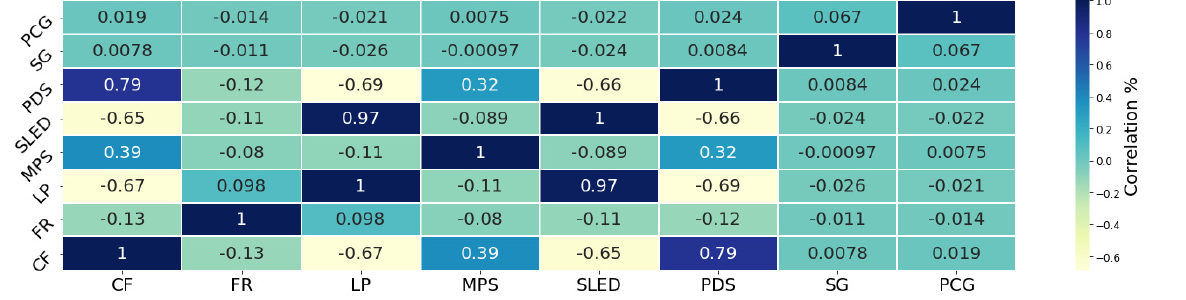
Figure 11. Heat map comparison of all features.